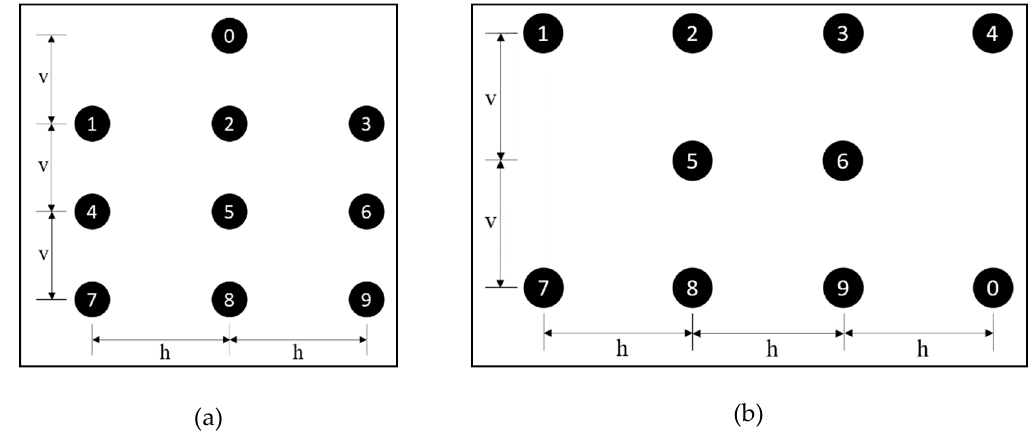
Figure 6. Configuration of vibration motors: ( a ) 1-3-3-3 configuration; ( b ) 4-2-4 configuration.